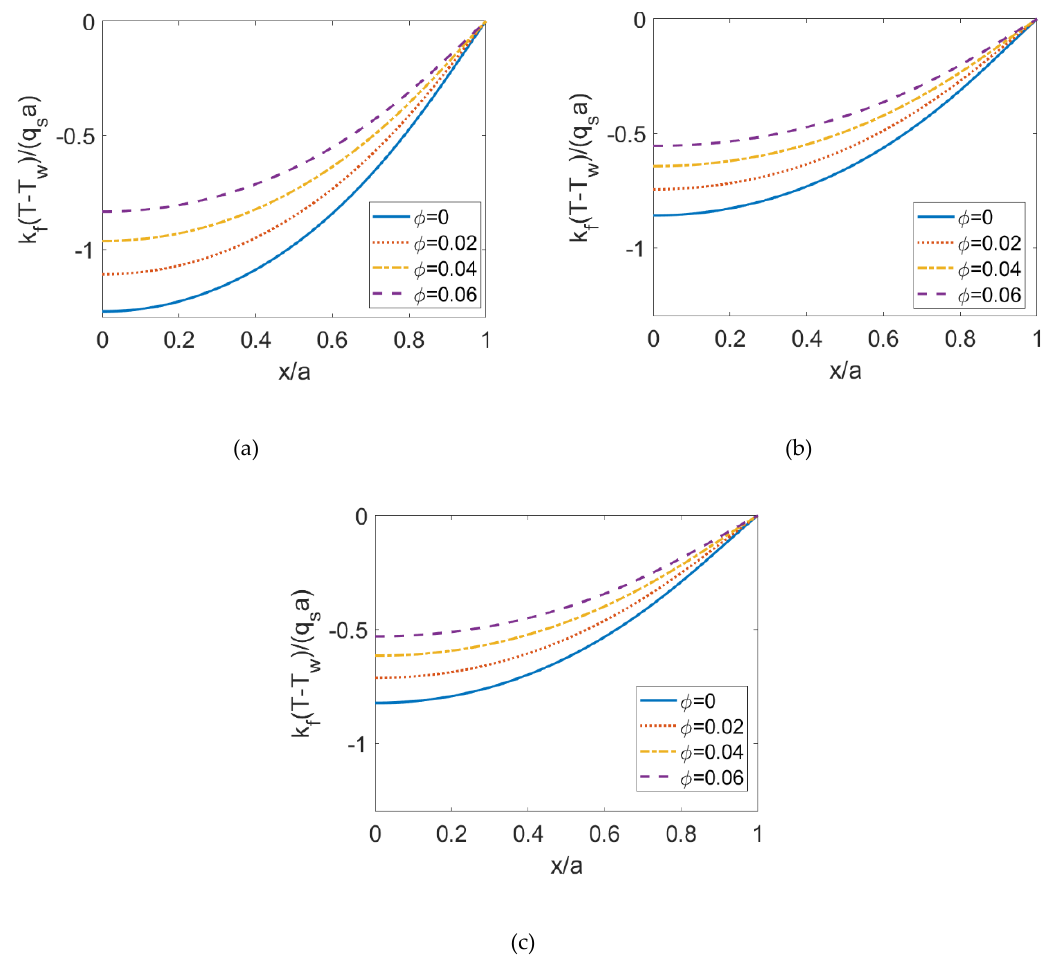
Figure 6. The comparison among temperature profiles at y = 0 for different nanoparticle volume fractions φ in the case of ( a ) n = 0.8, ( b ) n = 1.0 and ( c ) n = 1.2.